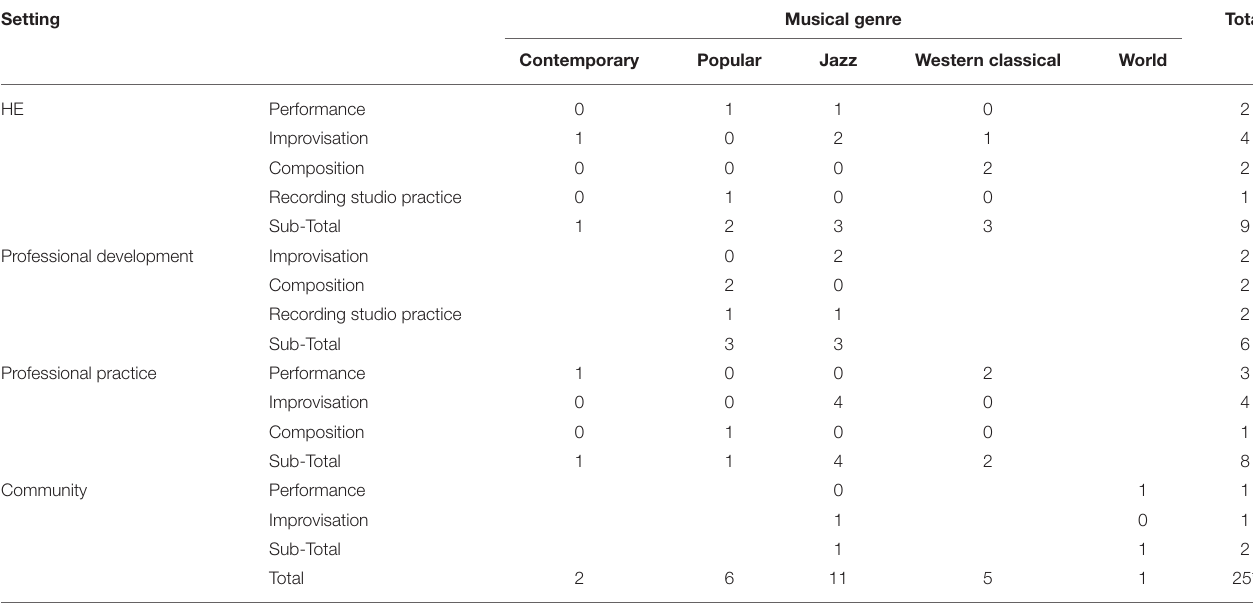
TABLE 6 | Musical genres represented in the research.